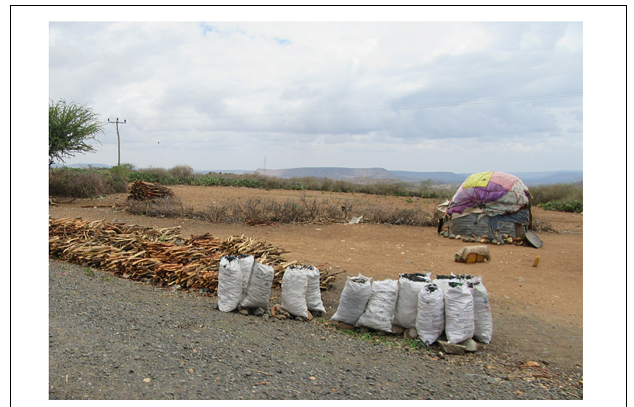
FIGURE 1 | Wood and bags of charcoal displayed for sale by the side of the road in the Somali region of eastern Ethiopia. Photo: Gad Perry.